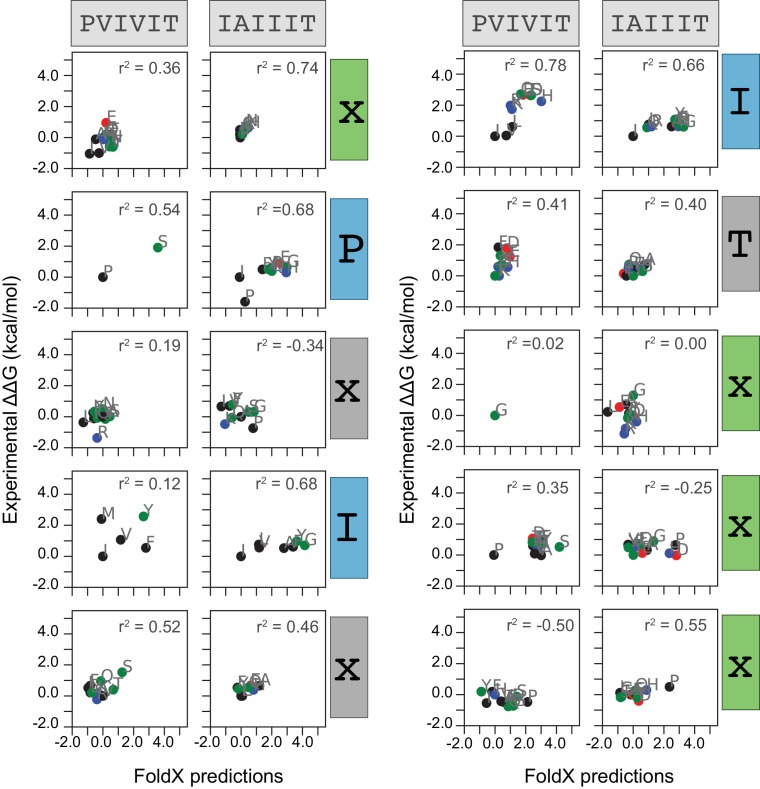
Measured versus FoldX-predicted changes in Gibbs free energies.Correlation between measured and FoldX-predicted change in Gibbs free energy for each mutation at each position within PVIVIT and AKAP79 peptides. Each panel includes calculated correlation coefficients between MRBLE-pep measured changes in binding affinity (y axis) and FoldX-predicted changes in binding affinity (x axis). Residues are colored by biochemical properties (red = acidic, blue = basic, black = hydrophobic, green = all other residues).